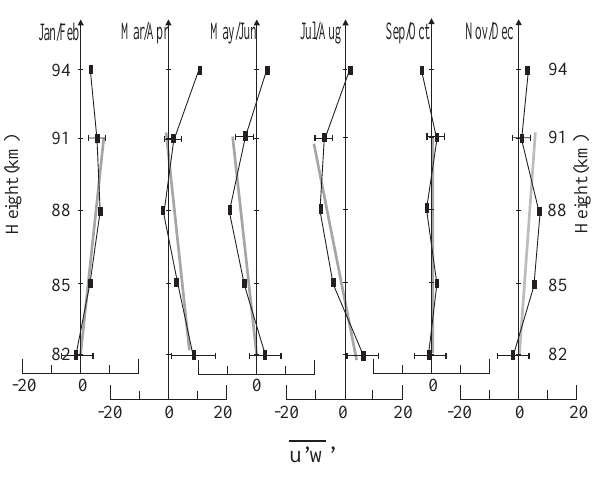
Fig. 4. Height profiles of mean values of u 0 w 0 for Resolute Bay, for the period July 2001 to September 2004, plotted as two-monthly